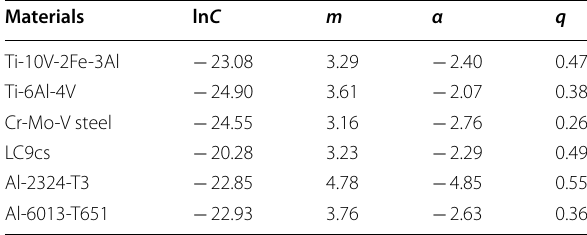
Table 6 SR model fitting parameters for various